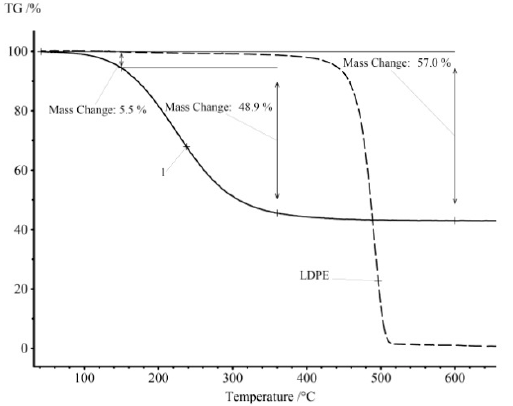
Figure 1. The results of the thermogravimetric analysis in an inert atmosphere for the pyrolysis product LDPE (curve 1) and the initial LDPE.